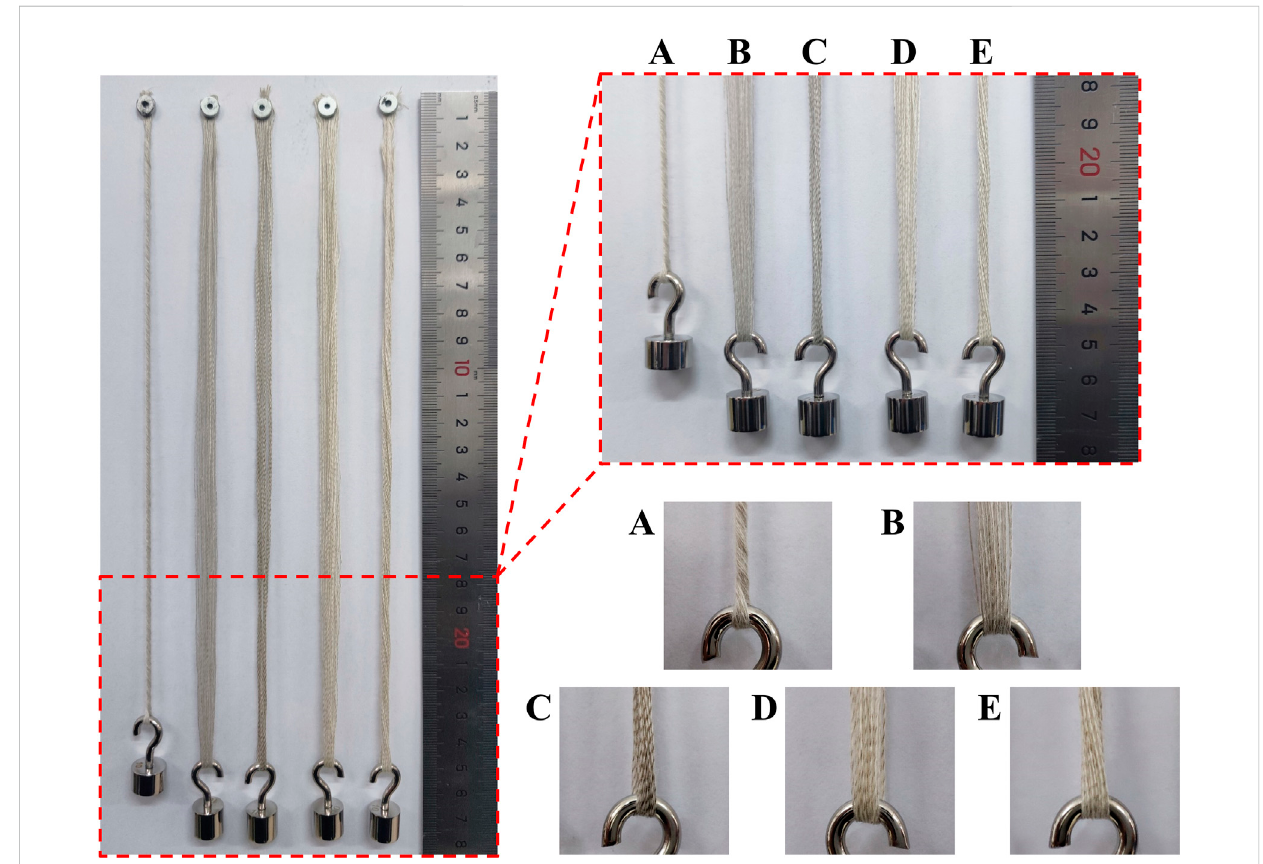
FIGURE 7 Snarlings of yarns with different parameters: (A) A f ; (B) A g ; (C) A h ; (D) A j and (E) A k .